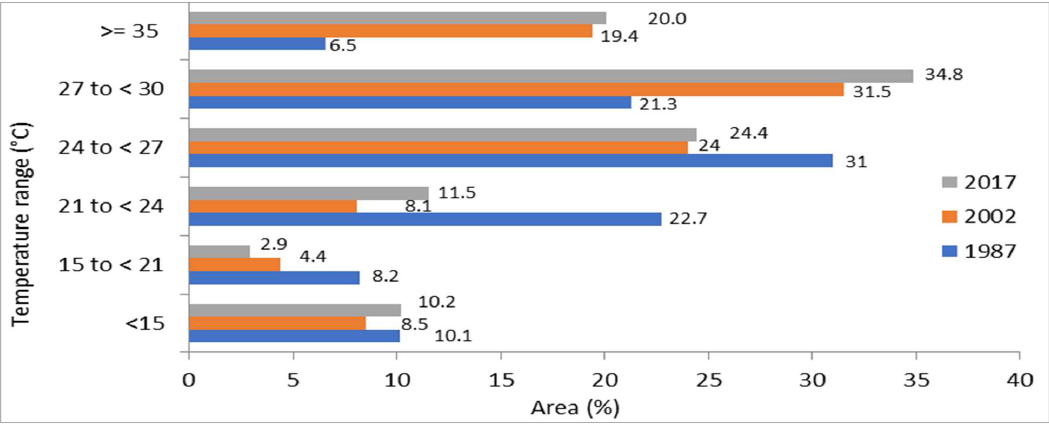
Figure 5. LST previous pattern for the respective years ( a ) 1987, ( b ) 2002, and ( c ) 2017.